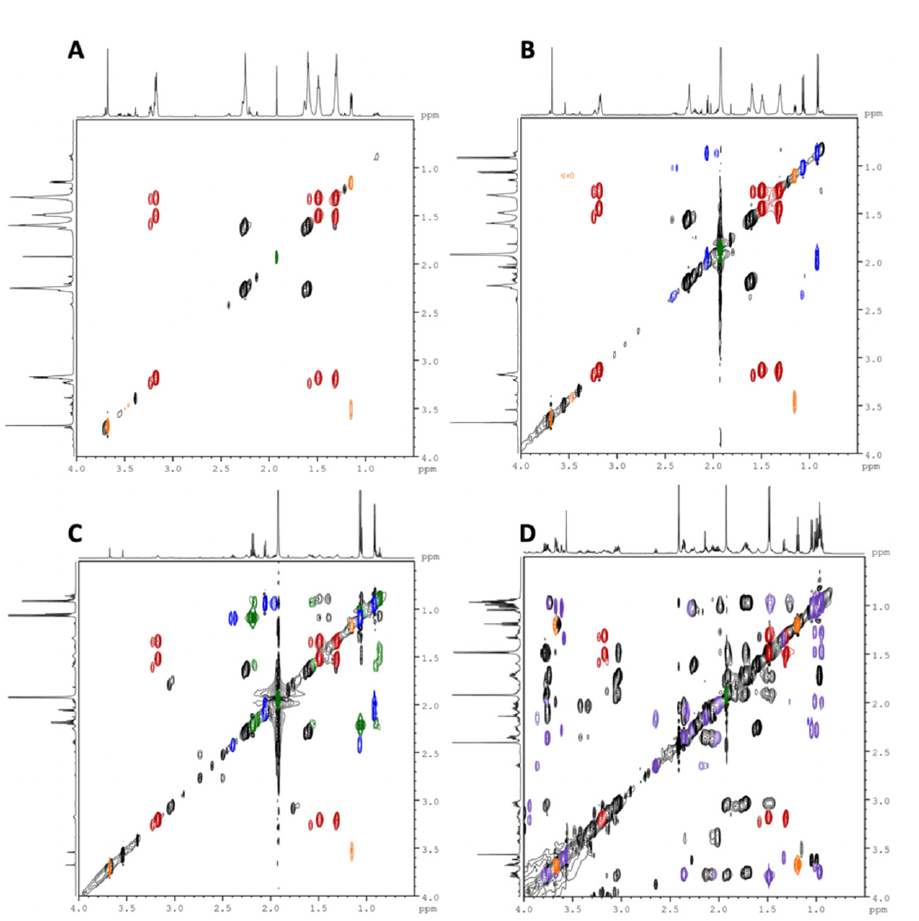
Figure 4. The aromatic region of the 1 H NMR spectra microcosm samples after 18 days of exposure to BAC for ( a ) 0 mg/L BAC, ( b ) 16.7 mg/L BAC, ( c ) 33.3 mg/L BAC, and ( d ) 66.7 mg/L BAC. Peaks for confirmed structures are numbered and are identified in Table 1.